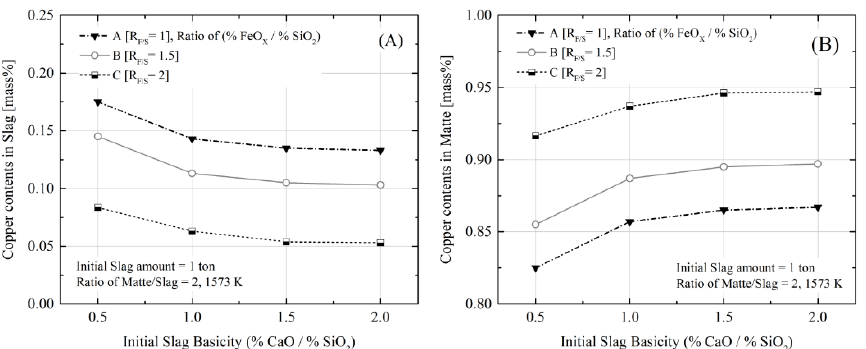
Figure 10. Simulation results of the copper content of the slag at 1573 K as a function of CaO/SiO 2 and FeO X /SiO 2 ratios at 1573 K. Figures ( A ) and ( B ) show Cu content in the slag and that in the matte, respectively. Table 6. Simulation conditions of the slag and matte as a function of the changes in the CaO/SiO 2 ratio and changes in the CaS/FeS ratio. Calc. No.